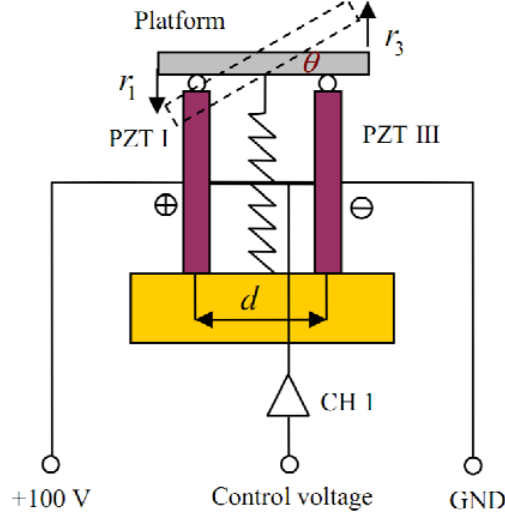
Figure 3. Working principle of the piezo-based platform in X-axis.